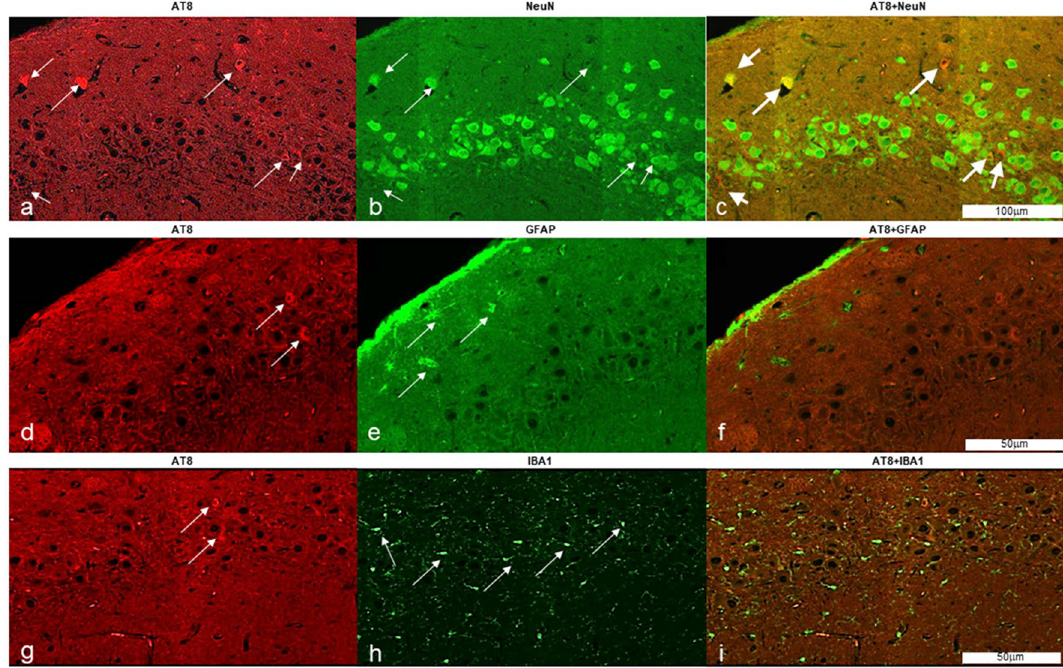
Figure 5. Hyperphosphorylated-Tau (pTau) accumulates in neurons after Hypobaric Exposure. Figure shows immunofluorescence reactivity for AT8 in hippocampal neurons of a HYPOBAR animal ( a – c ). AT8 did not colocalize with either astroglial ( d – f ) or microglial cells ( g – i ). Thin white arrows show AT8+, NeuN+, GFAP+ and IBA1+ positive cells in the hippocampal cortex of a HYPOBAR animal. Notice the specific accumulation of pTau (AT8) in neurons (Thick white arrows, c ).